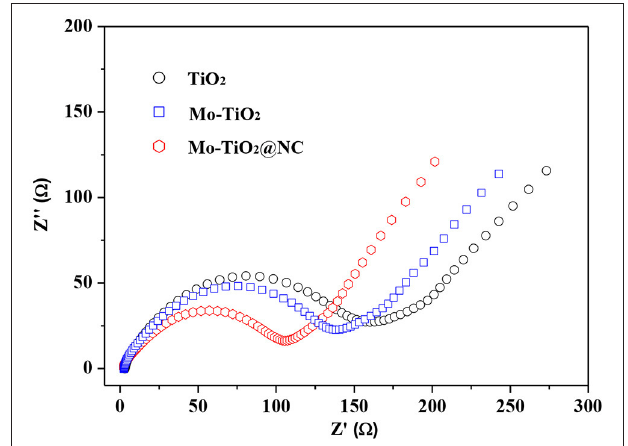
FIGURE 7 | Nyquist plots of TiO 2 , Mo-TiO 2 , and Mo-TiO 2 @NC electrodes before